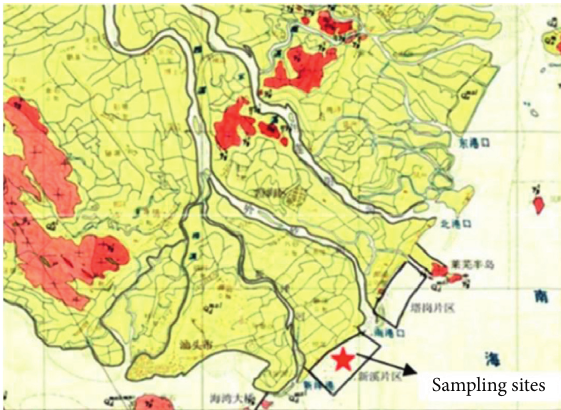
Figure 1: The sampling sites in Shantou city, China.